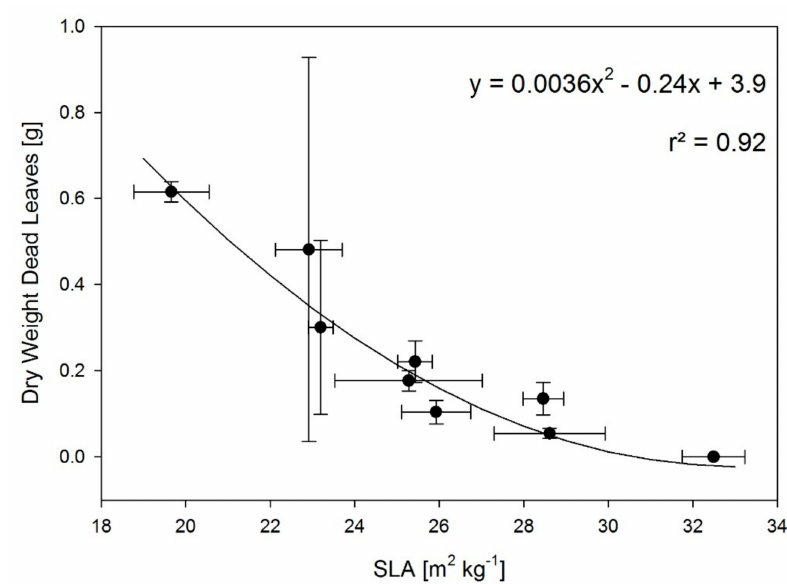
Figure 3. Correlation between SLA and dry weight of dead leaves per plant for plants subjected to di ff erent day and night temperatures and RHs. Mean values with standard errors of three replications are presented for 9 treatments, ( n = 9), i.e., treatments with the same daily mean